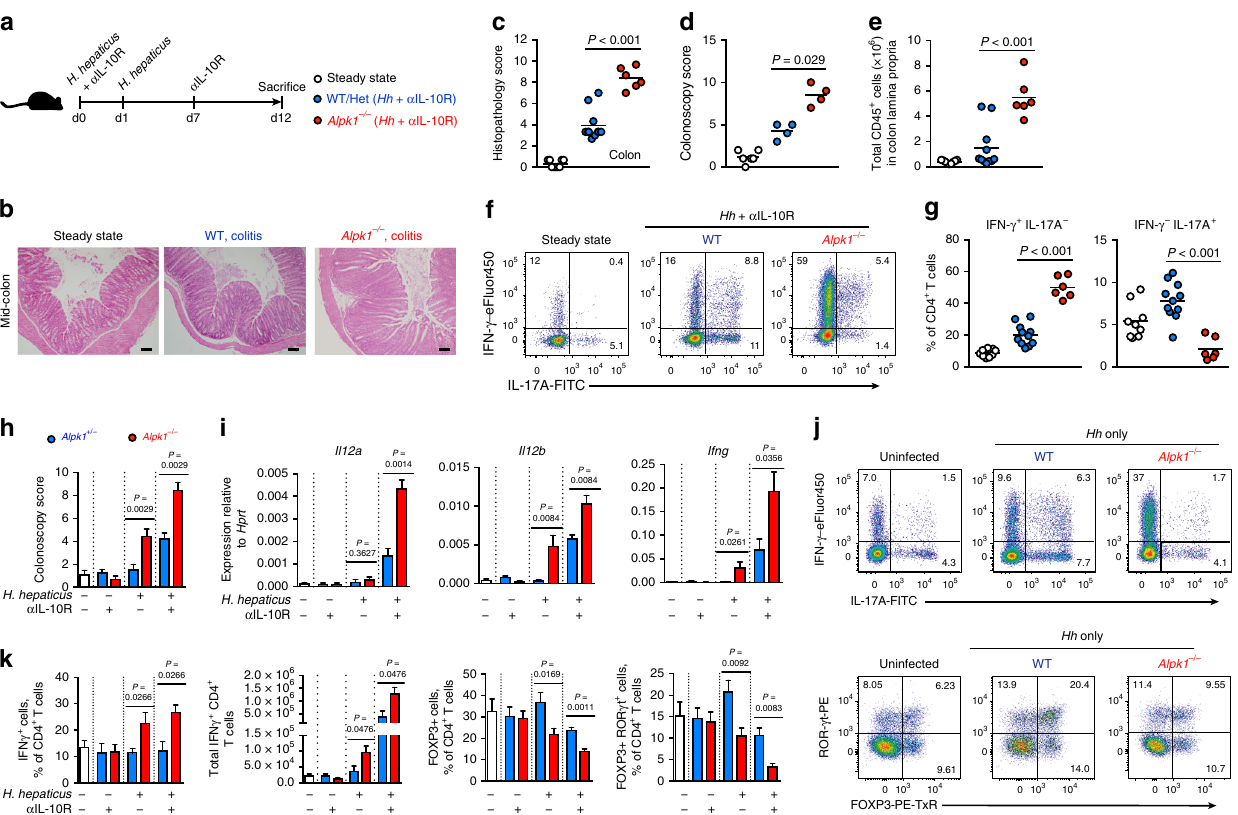
Fig. 3 Alpk1 de fi ciency in haematopoietic cells drives exacerbated colitis and intestinal Th1 responses in Hh -infected lymphocyte-replete